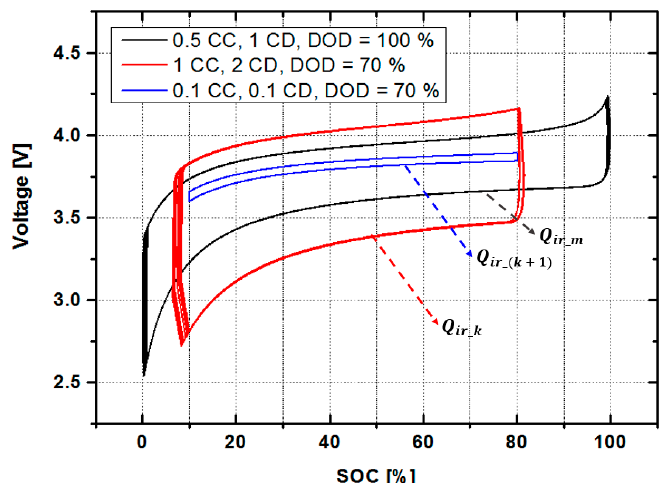
Figure 5. The irreversible energy in various situations.